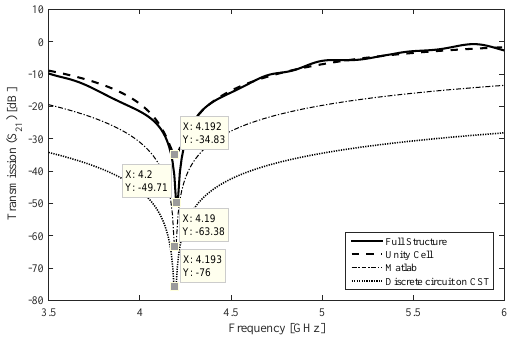
Figure 4: Comparison between the simulated results for unity cell, theoretical model, and the complete structure It can be seen that both unity cell and full structure re- sults agree, with its minimum at the desired frequency of 4 . 2 GHz. In addition, Table 1 the relative error in percent of the resonance frequencies theoretical models in relation to the measurement, whose frequency was